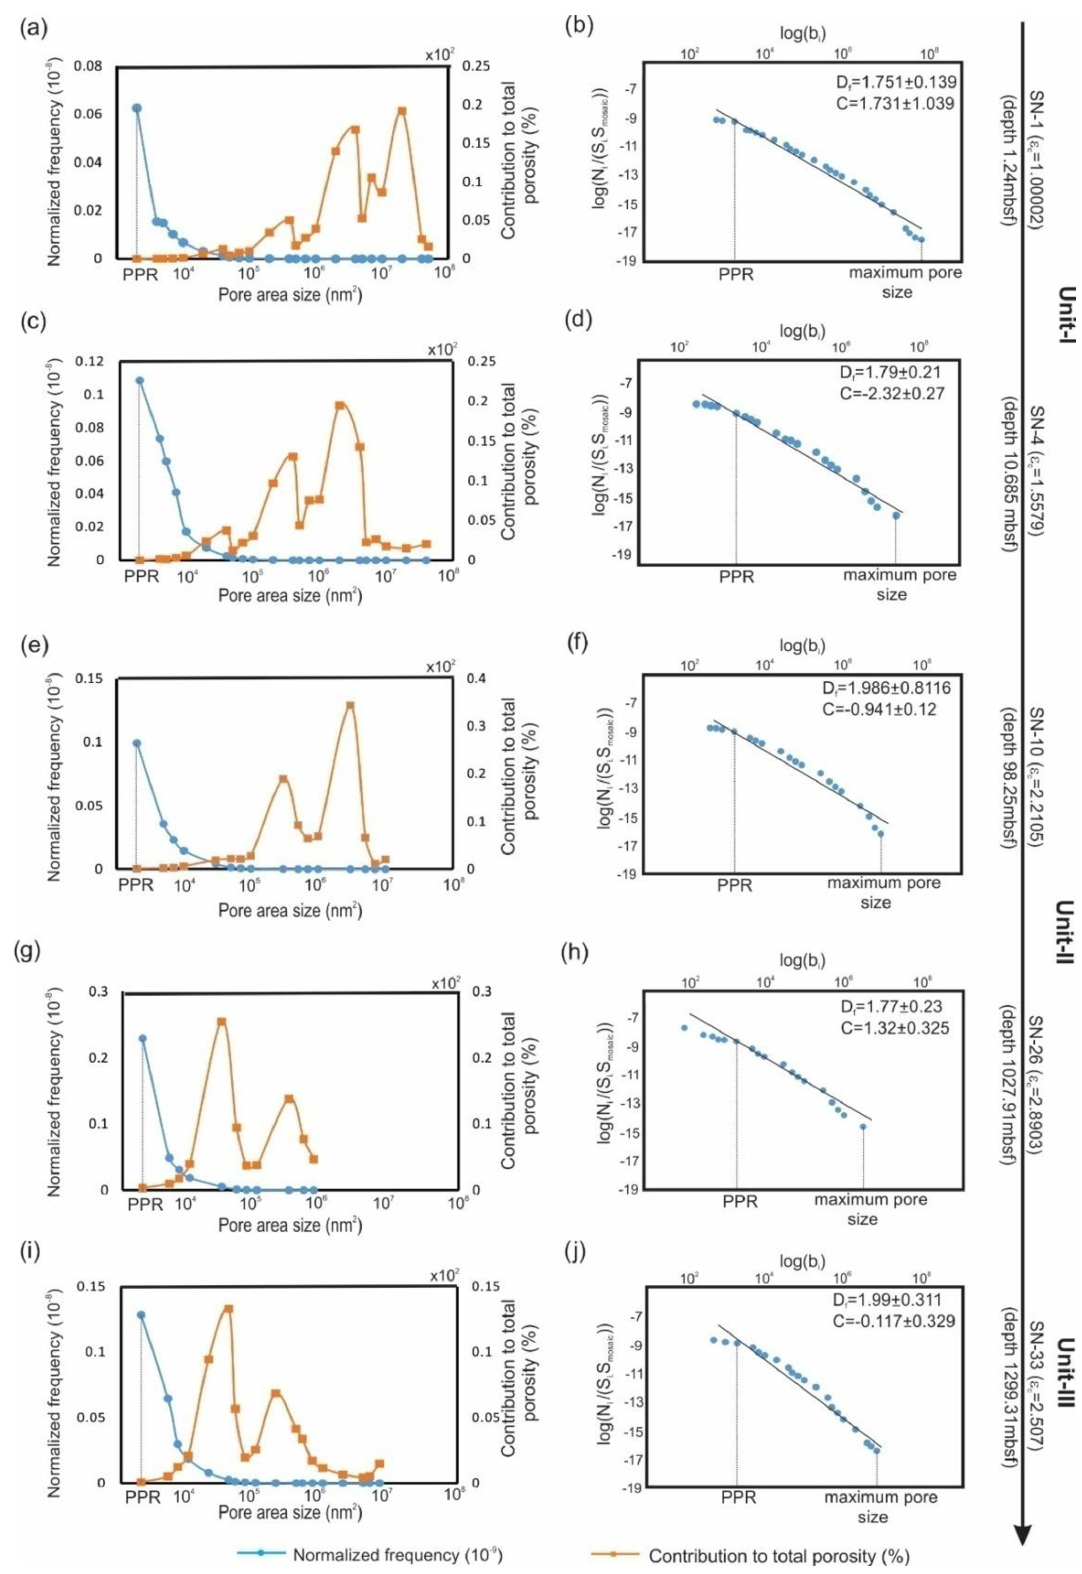
Figure 9. Pore size distribution defined by pore area. Left column: normalized frequency (blue) and contribution to total porosity (orange). Right column: pore size–frequency log–log distribution. The power law between PPR and maximum pore size is interpreted as a black line with corresponding regression parameters. Sample number, depth, and compactional strain are defined along the right side of the diagram. https://doi.org/10.5194/se-13-1513-2022 Solid Earth, 13, 1513–1539,